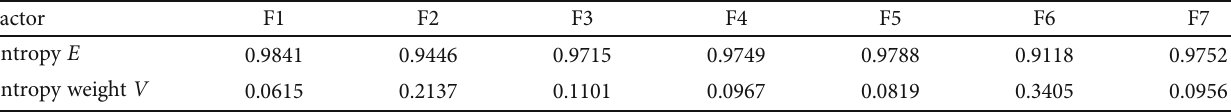
Table 4: The entropy and entropy weights of evaluation factors.